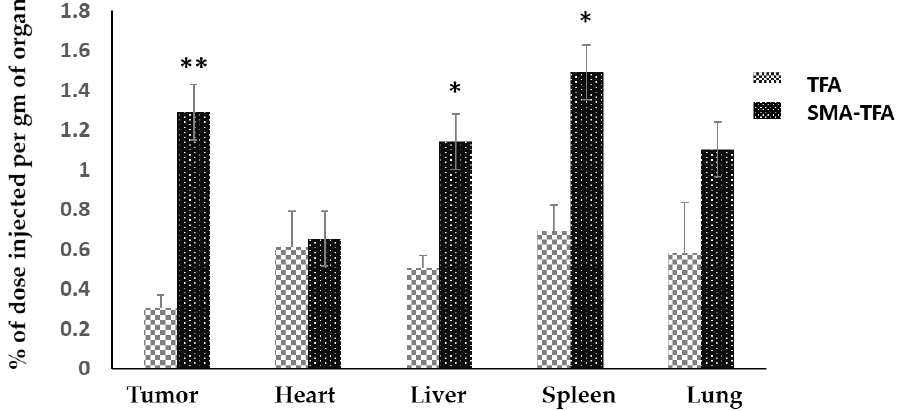
Figure 5. Tissue distribution of TFA and SMA – TFA at 24 h after intravenous injection of TFA or SMA – TFA (20 mg/kg) to Balb/c mice bearing 4T1 tumors ( n = 5). Representation of the content of TFA per tissue expressed as the percentage of injected dose. * p < 0.05 and ** p < 0.01 when comparing TFA to SMA – TFA. Data are expressed as the mean ± SEM ( n = 5).